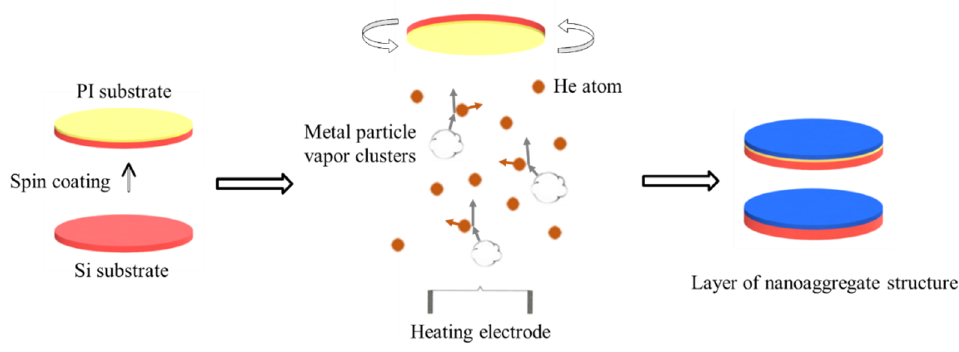
Figure 1. Process for fabricating layer of nanoaggregate